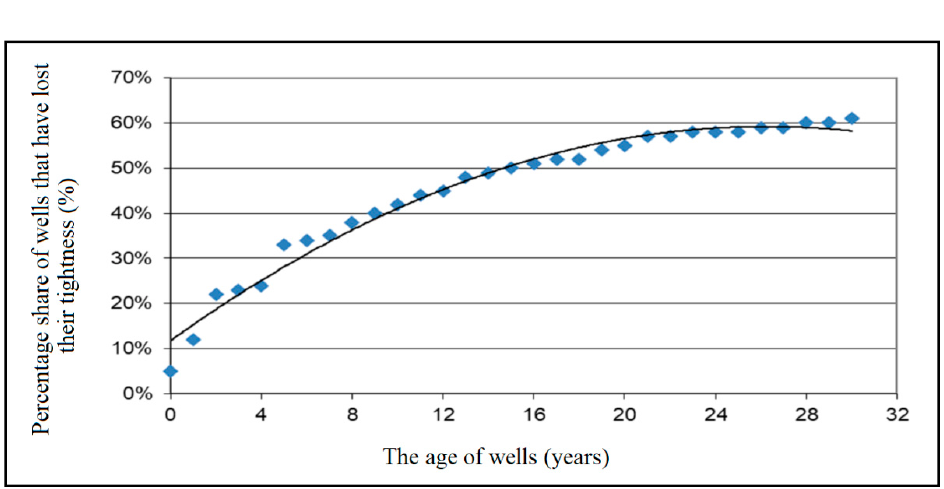
Figure 11. Influence of well ageing on the emergence of pressure in the annular space